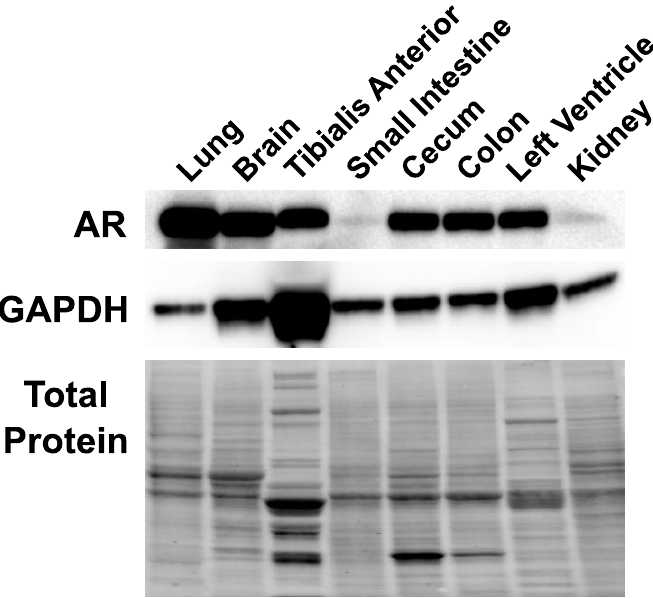
Figure 2. Androgen receptor protein expression in multiple tissues. Androgen receptor protein expression was analyzed by Western blot. Equal amounts of protein extracts (50 µg total protein) were analyzed for each tissue. GAPDH is shown to represent protein expression across tissues as a positive loading control. The total protein is shown by the use of Stain-Free total protein staining technology.